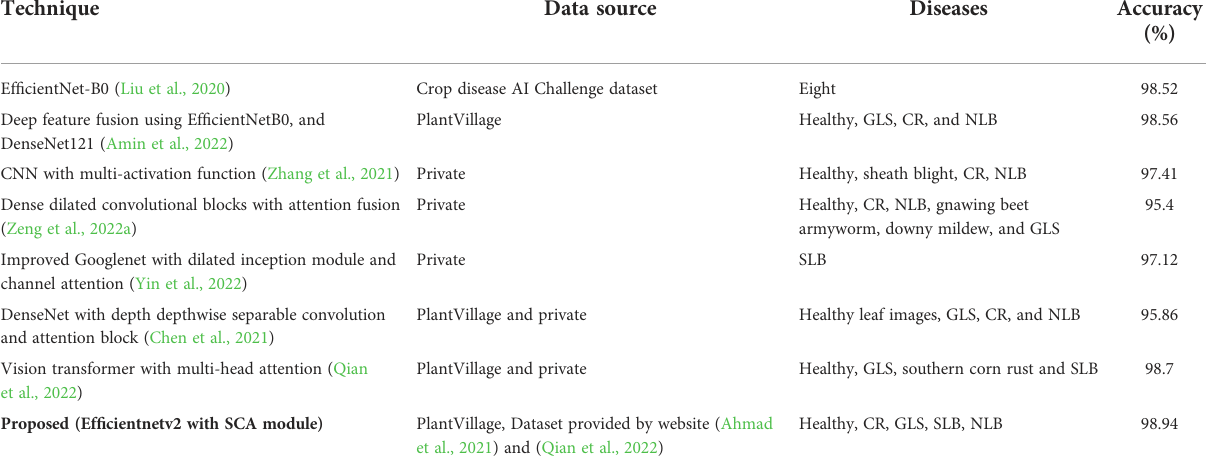
TABLE 6 Comparison of the proposed technique with other